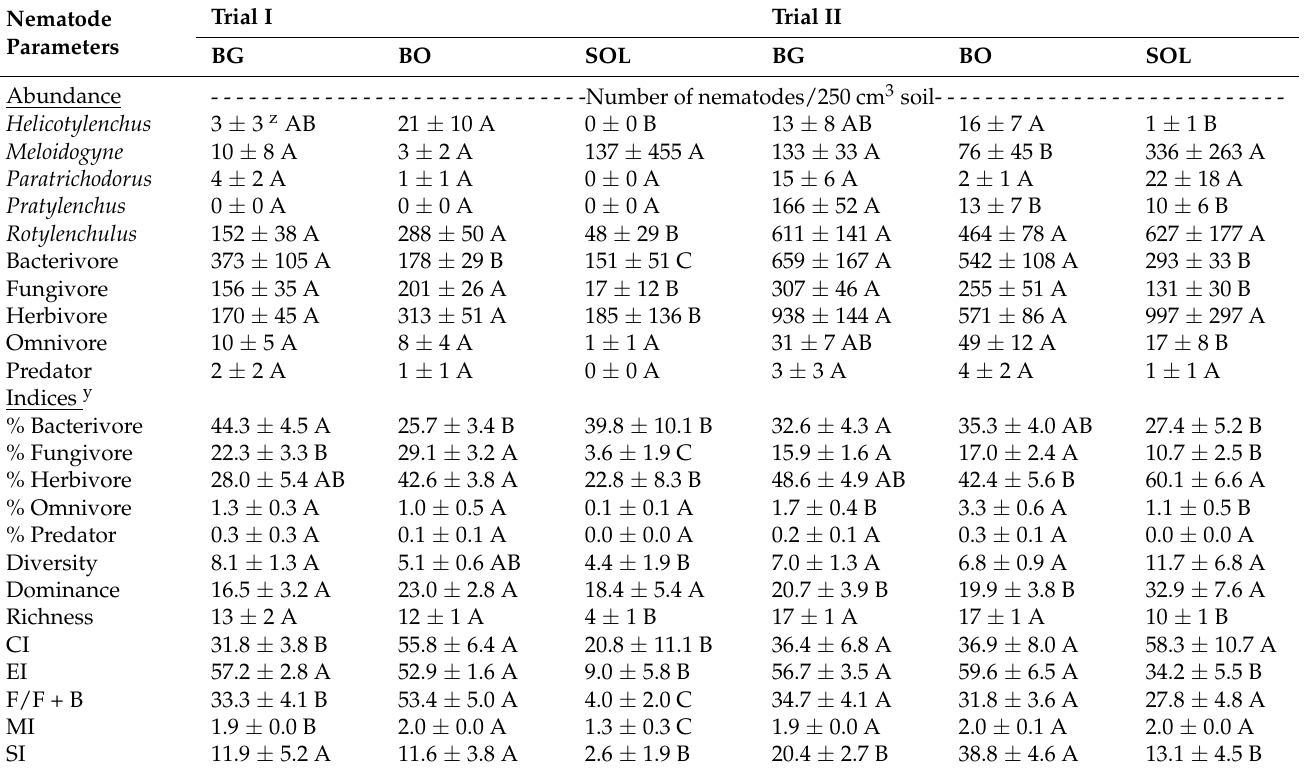
Table 3. Effect of no-till cover cropping with black oat (BO) on nematode communities compared to bare ground (BG) and soil solarization (SOL) treatments during the corn growing